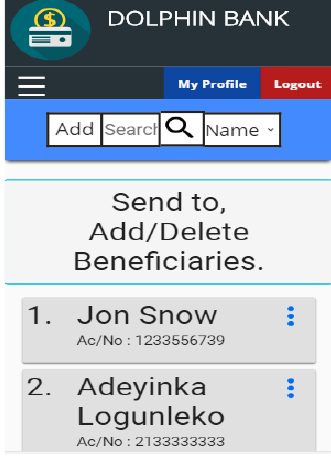
Fig. 11. List of Beneficiary Page